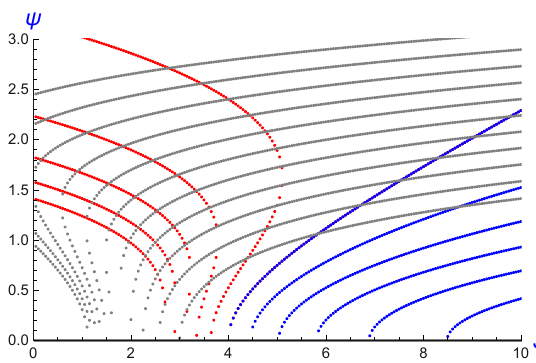
Figure 8. Plot of vs J for the toy system (A.1). We have chosen m 1 = m 2 = 1. The grey lines are generated for (cid:12) = 0, (cid:11) 1 = 0 : 5 = (cid:11) 2 and (cid:21) is varied between 1.0 and 2.0. While the Red and Blue curves are generated for (cid:21) = 0, (cid:11) 1 = 1 = (cid:11) 2 and (cid:12) varied between 0.5 and 1.5. The red curves are obtained when (cid:12) is greater than 1.0, which is higher than the self-interactions (cid:11) 1 and (cid:11) 2